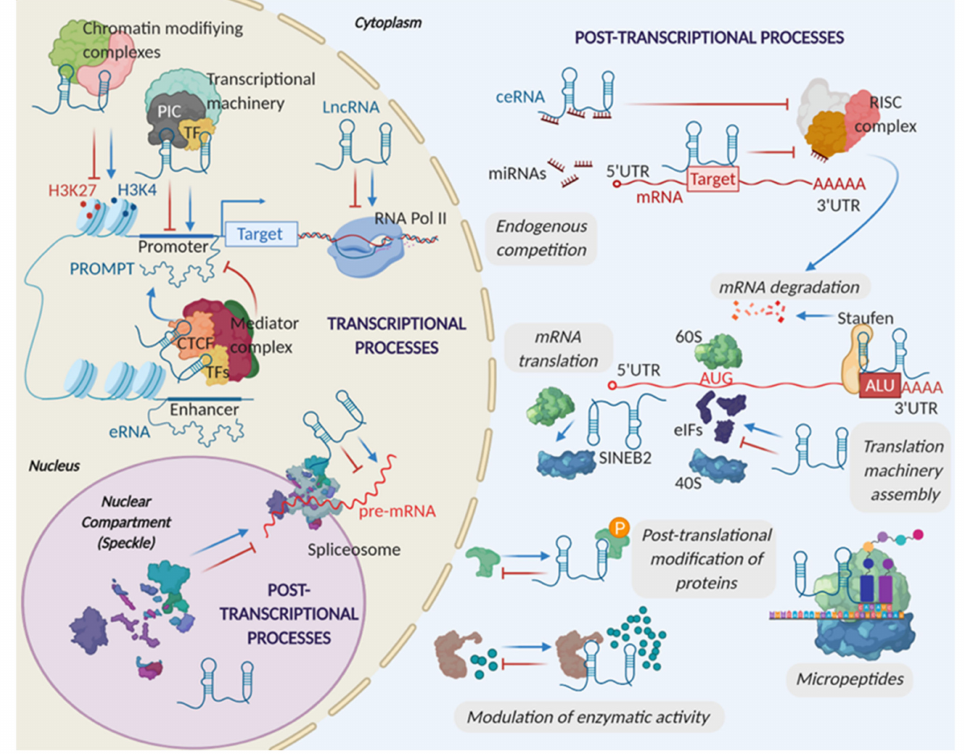
Figure 2. LncRNAs a ff ect protein activity directly or by regulating transcriptional and post- transcriptional processes in the nucleus (on the left) or in the cytoplasm (on the right). These e ff ects result from the ability of lncRNAs to form primary, secondary, and tertiary structures able to bind DNA, RNA, or proteins. See text for details. Blue arrows depict activation while the red arrows,